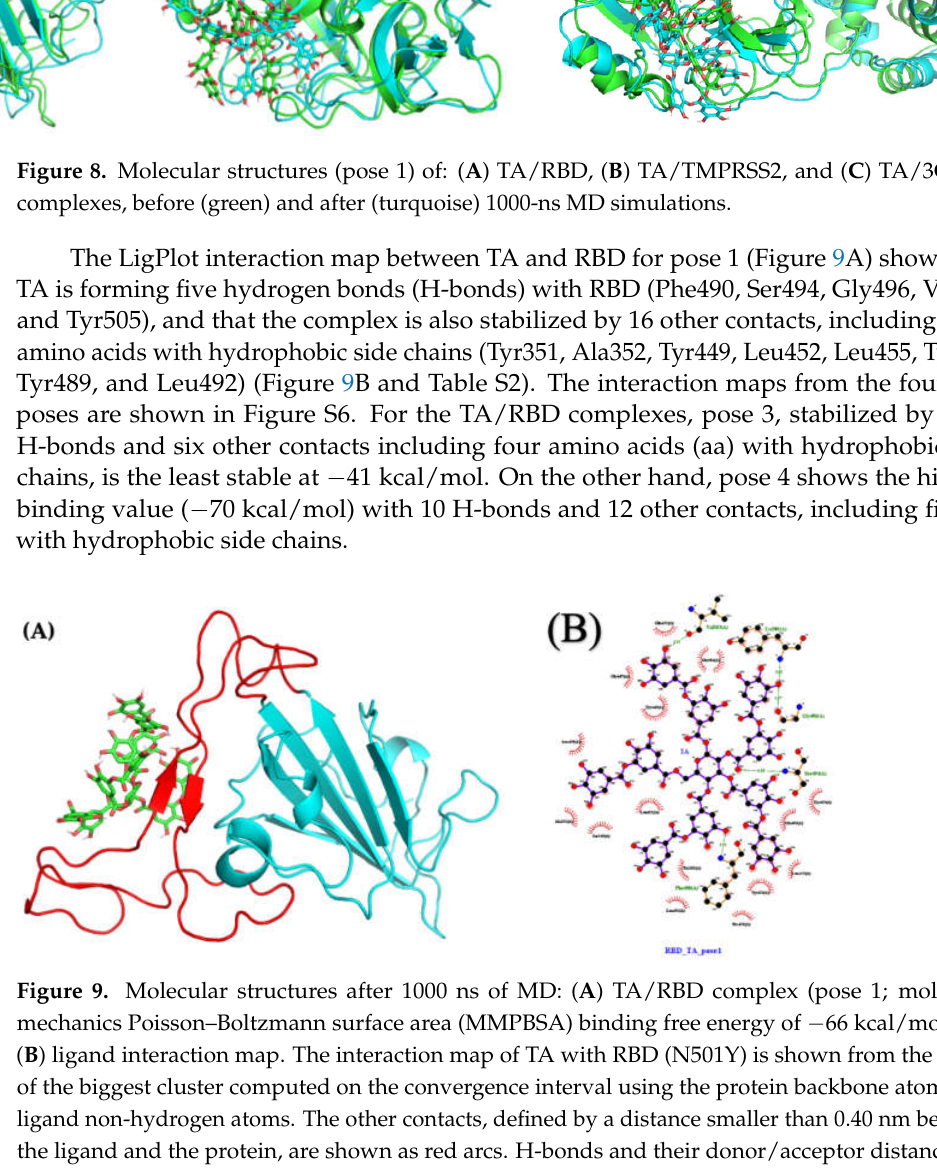
the ligand and the protein, are shown as red arcs. H-bonds and their donor/acceptor distances are shown in green. The interaction map is generated using LigPlot [50,51].